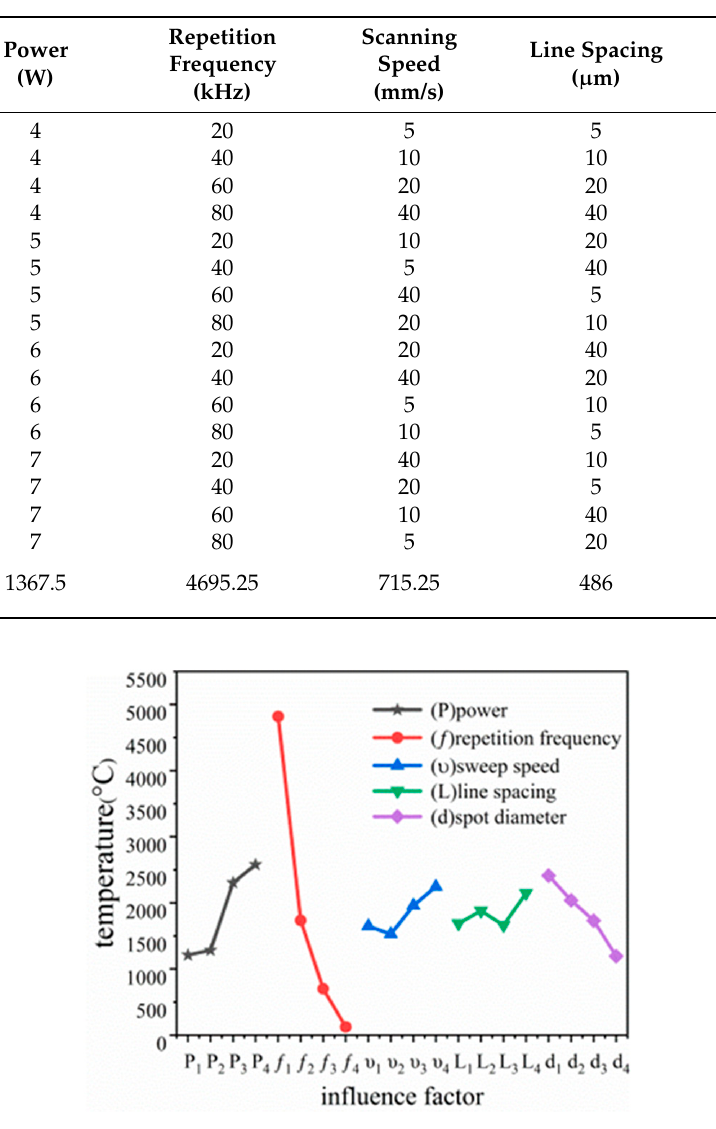
Table 1. Orthogonal experiments for laser processing simulation.